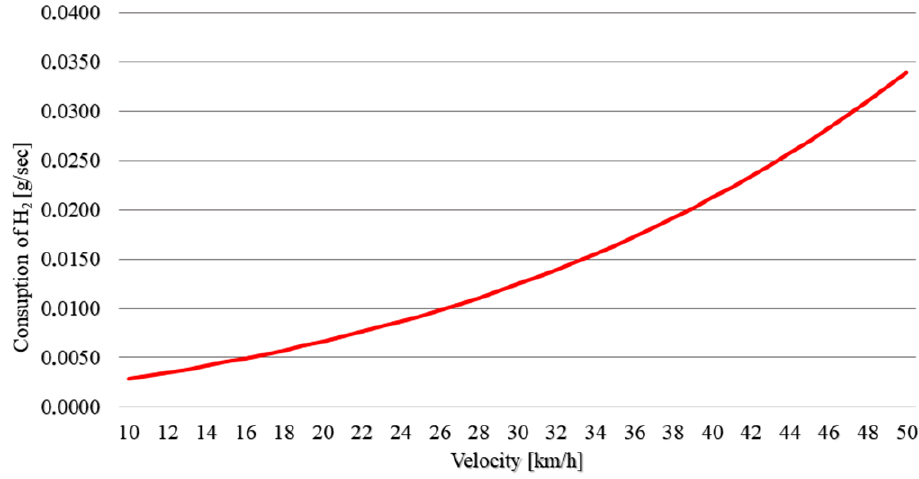
Figure 7. Consumption of H2 in g/sec, in relation to the velocity of the vehicle.